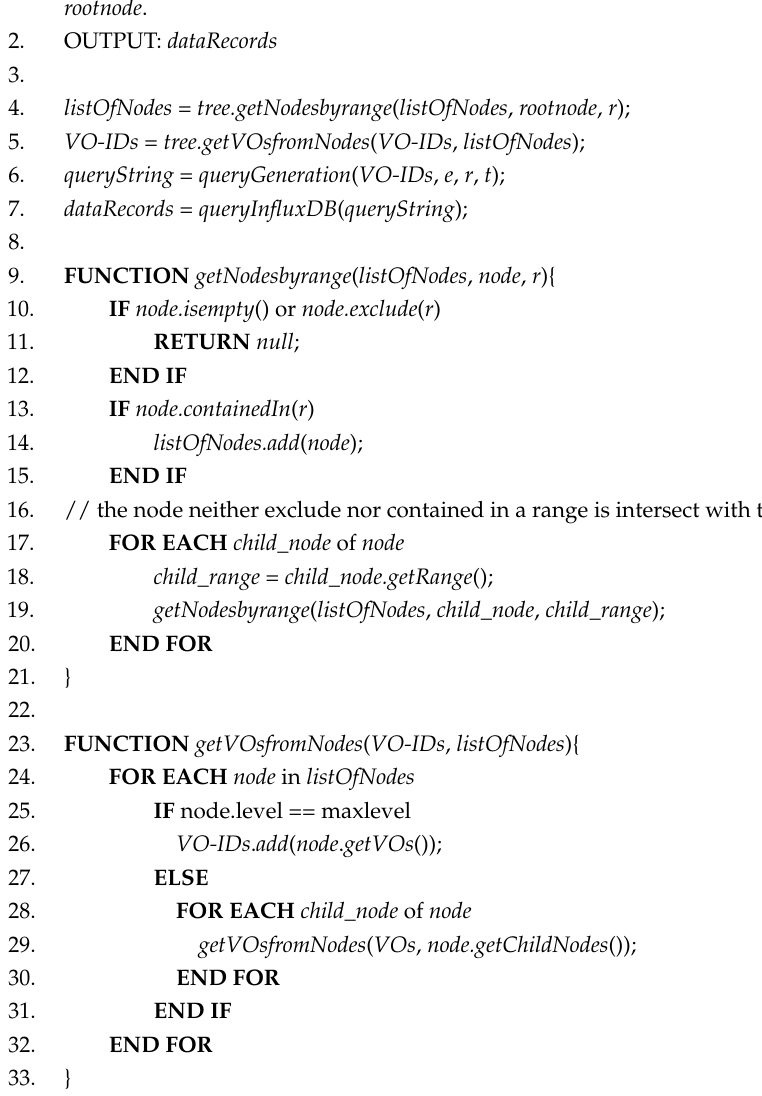
Algorithm 2: Query Mechanism of Geohash-Grid Tree and